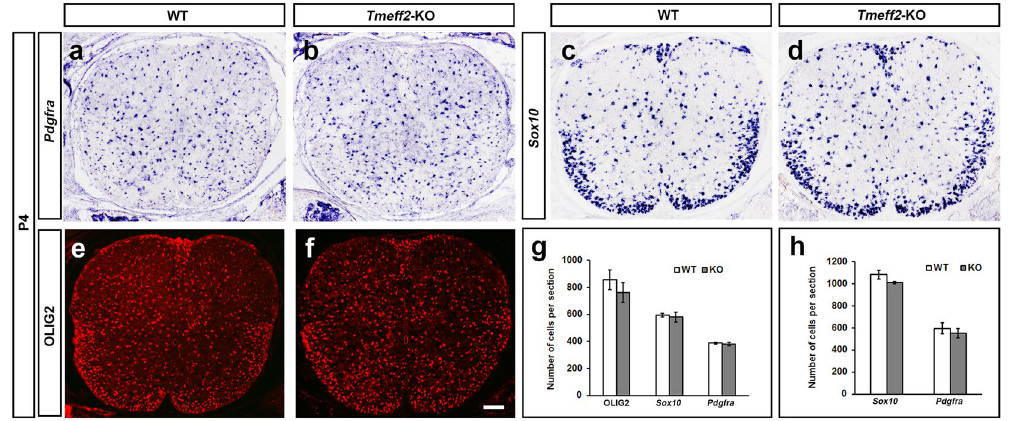
Figure 5. The number of OPCs is not affected in Tmeff2 -KO mutants. ( a–f ) Expression of Pdgfra ( a,b ), Sox10 ( c,d ) and OLIG2 ( e,f ) as detected by ISH or immunofluorescence in wild type and mutant spinal cords at P4. Bar, 100 μ m. ( g,h ) Statistical analysis of OLIG2 + , Sox10 + and Pdgfra + OPCs in P4 ( g ) and P8 ( h ) spinal cords. n = 3, p >